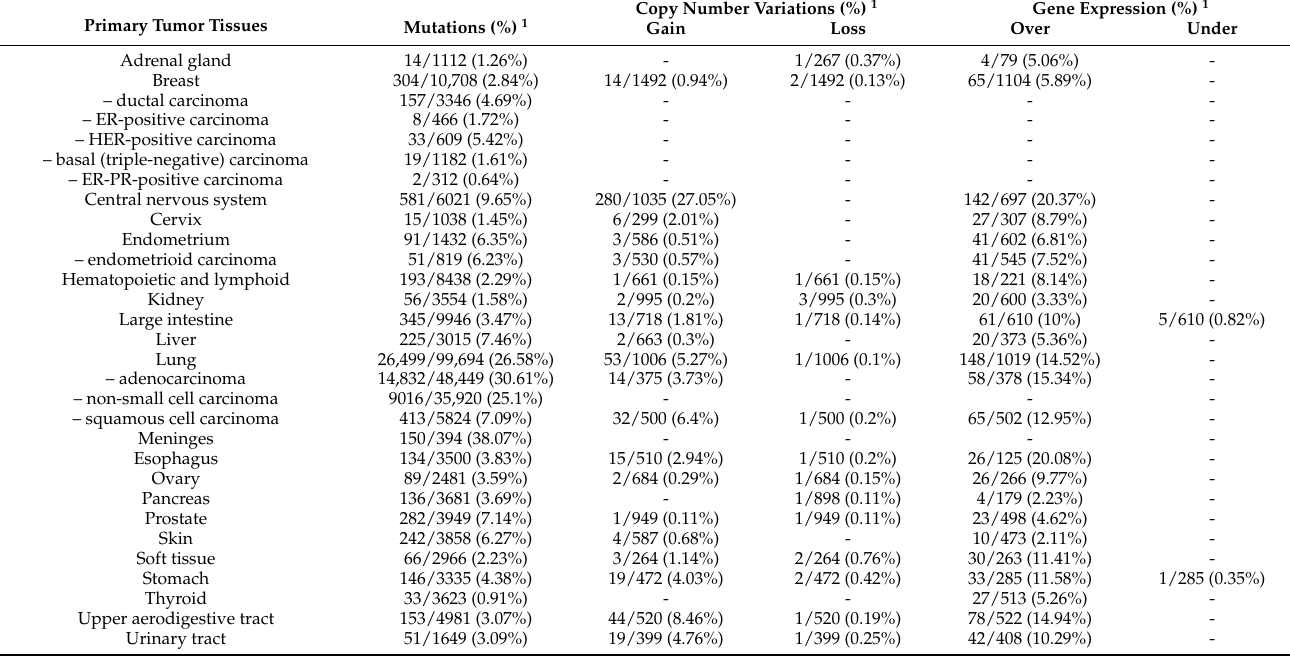
Table 3. Genetic alterations of EGFR in human